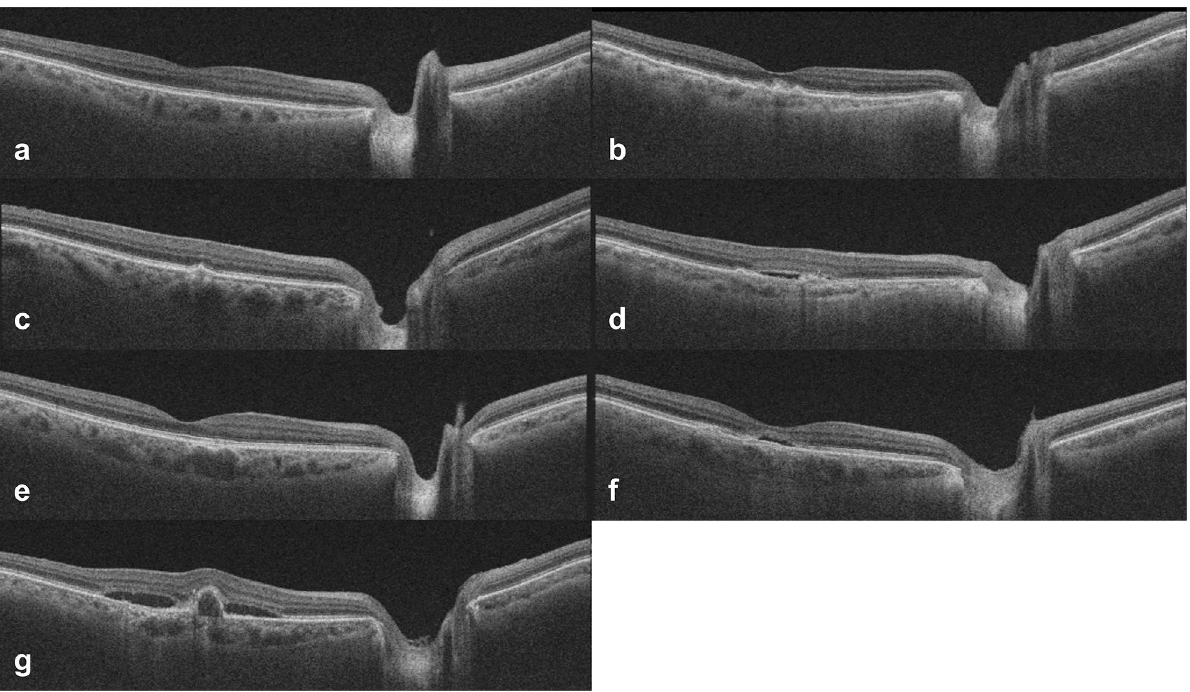
Figure 3. Representative swept-source optical coherence tomography images of eyes with ( a ) normal control, ( b ) early age-related macular degeneration (AMD) with soft drusen or reticular pseudodrusen, ( c ) pachydrusen, ( d ) classic exudative AMD, ( e ) pachychoroid pigment epitheliopathy, ( f ) pachychoroid neovasculopathy, and ( g ) polypoidal choroidal vasculopathy. The subfoveal choroidal thicknesses (CT), peripapillary CTs and the ratios of subfoveal CT to peripapillary CT are ( a ) 287 μm, 117 μm, 2.45, ( b ) 142 μm, 102 μm, 1.39, ( c ) 322 μm, 141 μm, 2.28, ( d ) 143 μm, 78 μm, 1.83, ( e ) 337 μm, 154 μm, 2.19, ( f ) 347 μm, 188 μm, 1.85, and ( g ) 264 μm, 132 μm, 2.00,